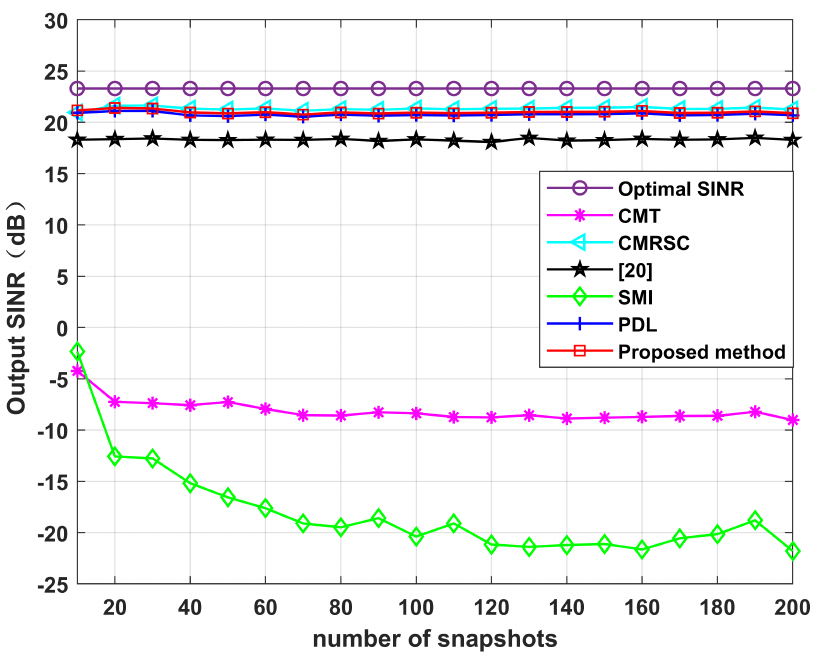
Figure 16. Output SINR versus the number of snapshots in the case of a DS with a + 5 ◦ deviation. Simulation 6.